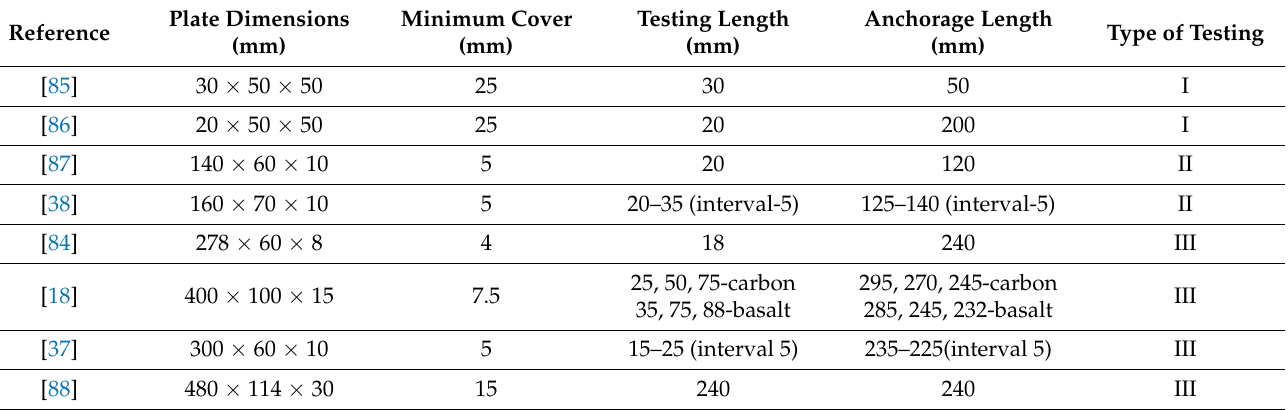
Table 2. Different specifications of pull-out test